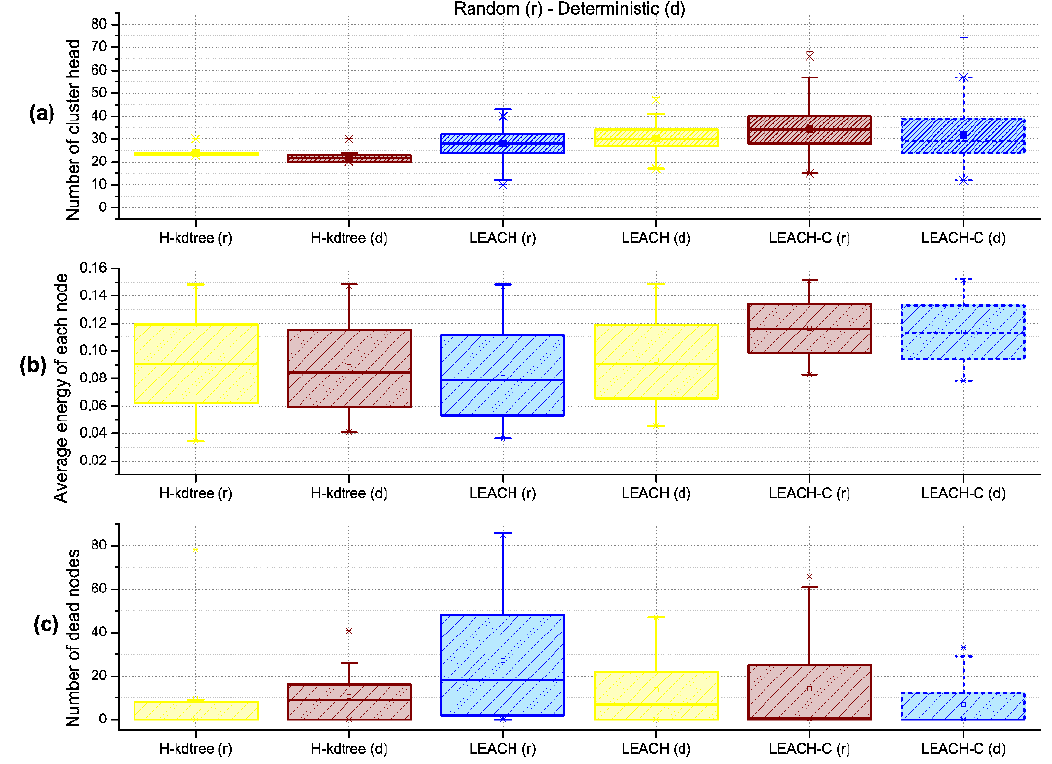
Figure 17. General energy metrics with 200